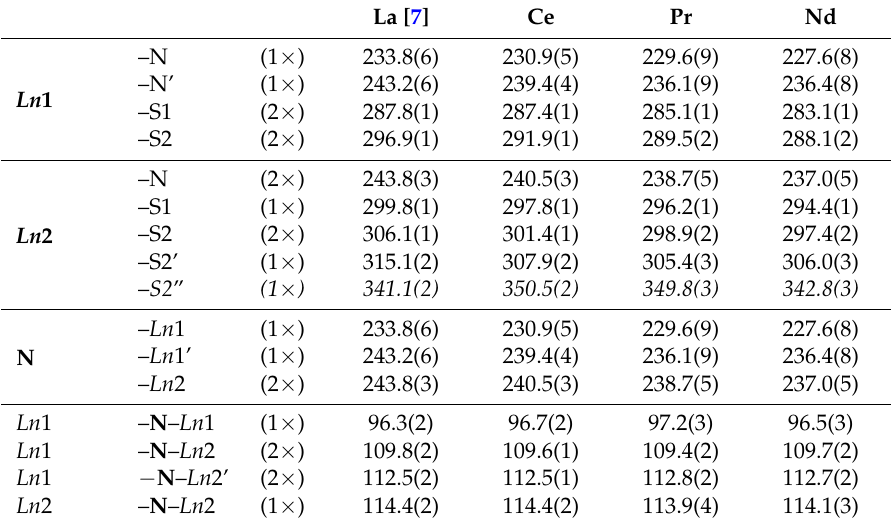
Table 4. Selected interatomic distances ( d /pm) and angles ( ∡ /°) for the three members of the Ln 4 N 2 S 3 series ( Ln = Ce–Nd) compared to A-type La 4 N 2 S 3 .